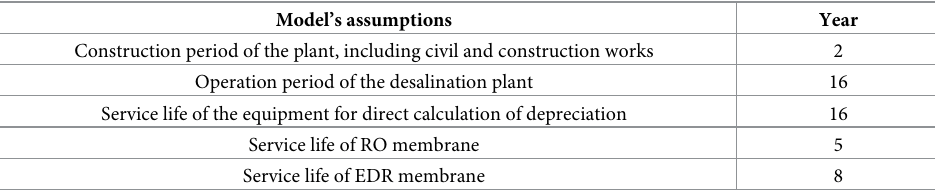
The development phase using the 2-stage RO + the EDR module